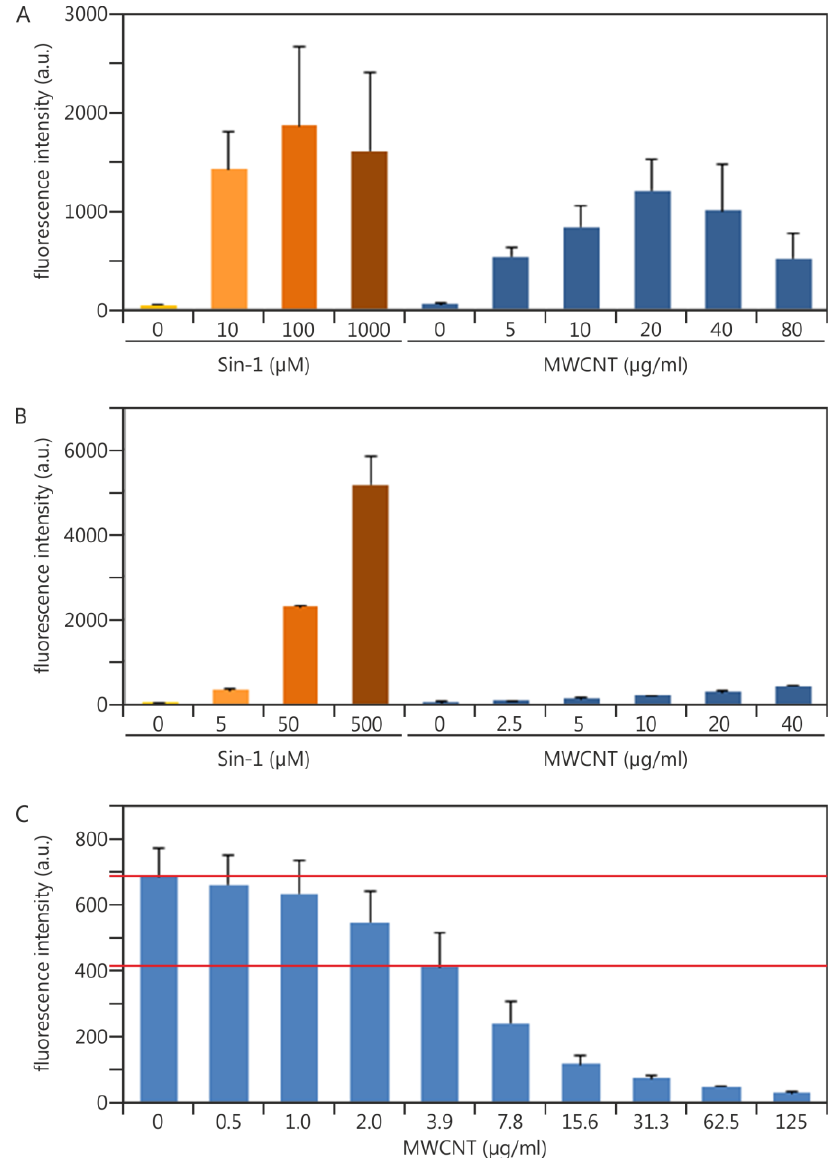
Figure 4. Cell-based 2',7'-dichlorodihydrofluorescein (DCF) assay and corresponding cell-free nanoparticles (NP) interference controls: For each graph, three independent experiments and their standard deviations are shown. In each case, fluorescence was measured after three hours of incubation. ( A ) A549 cells treated with increasing concentrations of Sin-1 and multiwalled carbon nanotubes (MWCNTs), respectively; ( B ) The deacetylated form of H DCF, incubated with increasing concentrations of Sin-1 2 and MWCNTs, in a cell-free environment to estimate the intrinsic oxidative potential of MWCNTs; ( C ) The already fluorescent molecule, DCF, incubated with increasing concentrations of MWCNTs to assess possible quenching